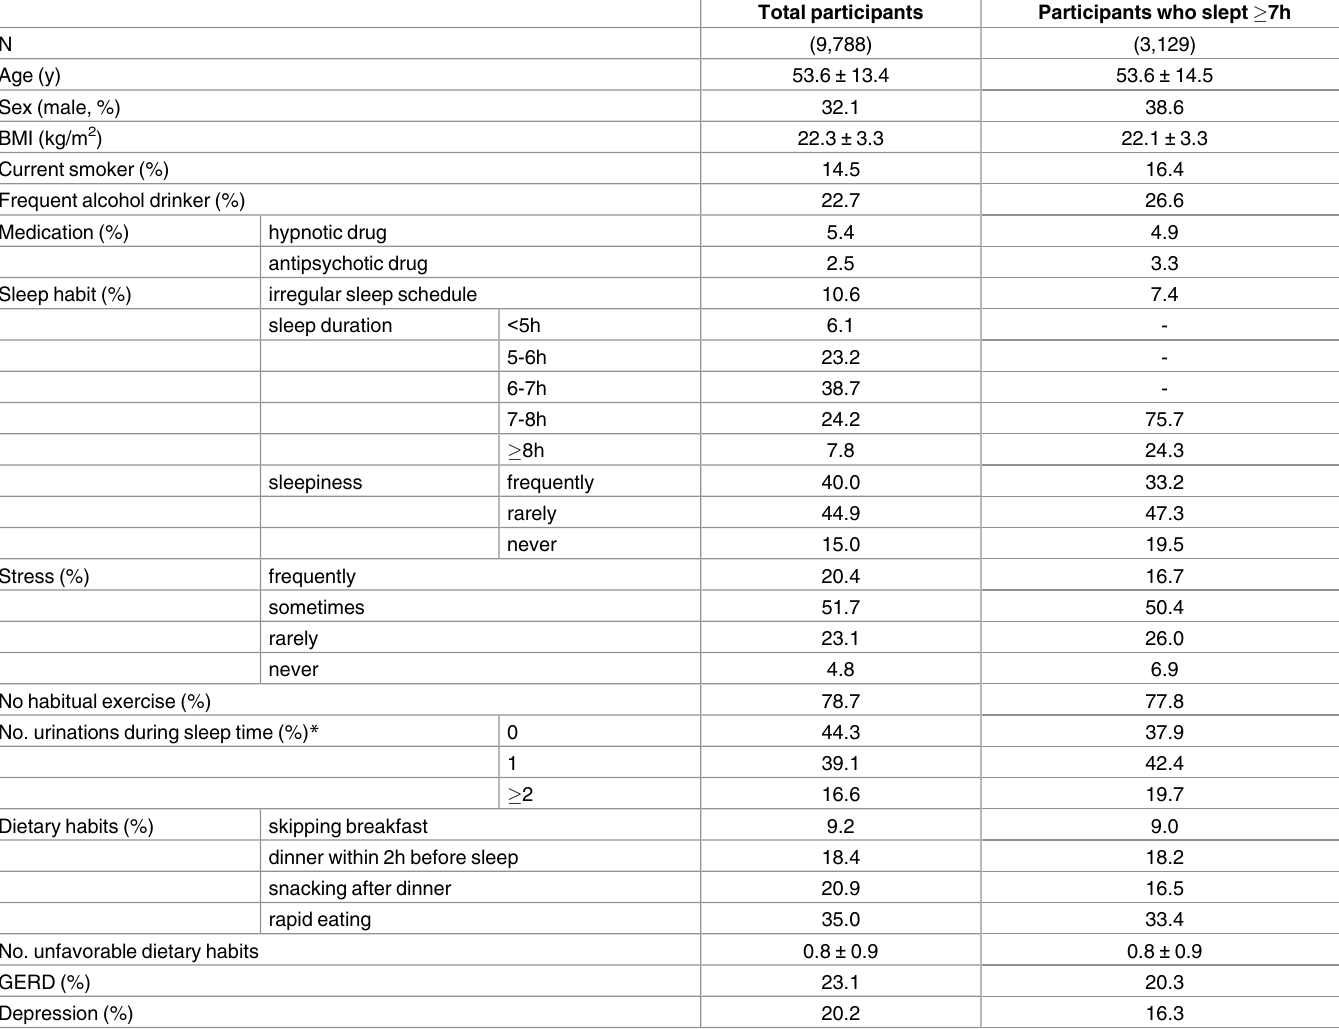
Table 1. Clinical characteristics of study